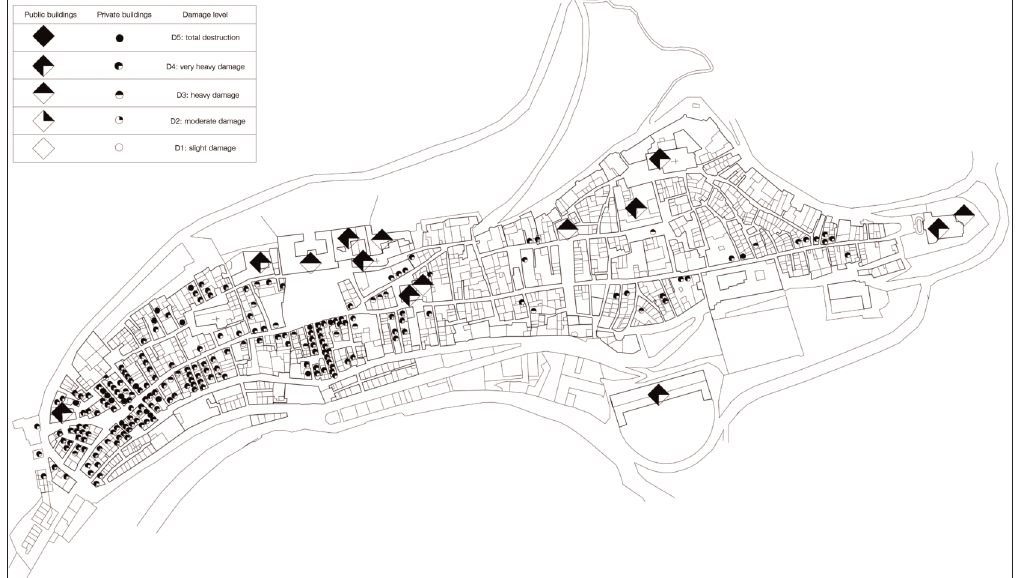
Fig. 7. 1857 damage ‘scenario’for Potenza. It is evident that the effects are mainly localised in the western and central-western sector of the historical centre, the so-called Portasalza and Portamendola quarters, where many buildings collapsed (see also fig.